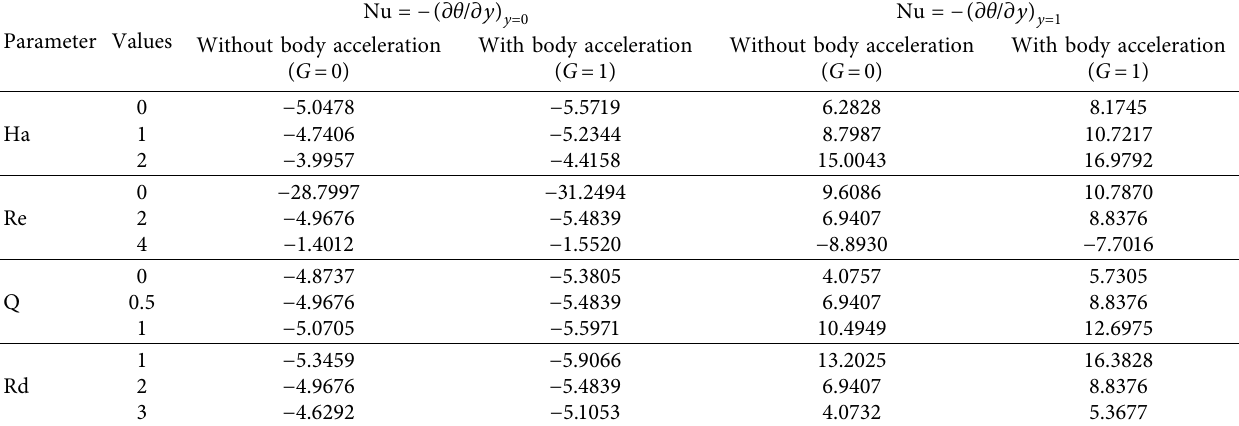
for channel with and without periodic body acceleration,